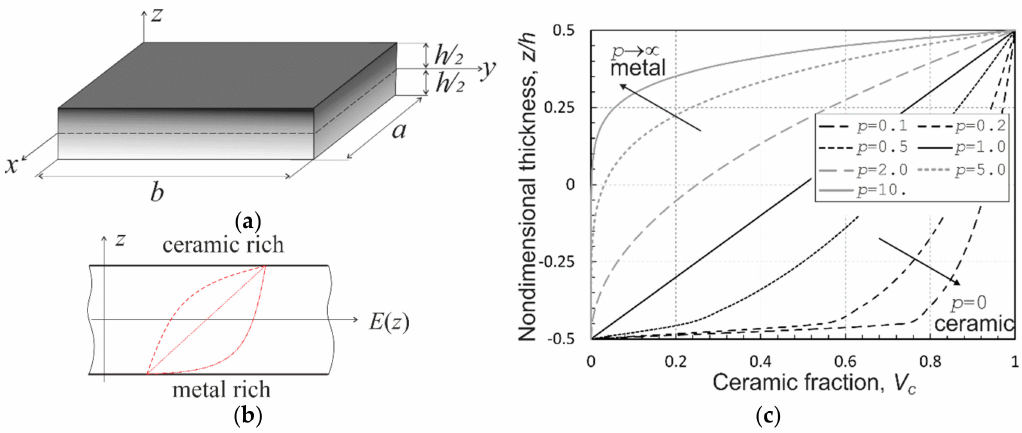
Figure 1. Sketches of: ( a ) functionally gradient material (FGM) sandwich panel; ( b ) through-the-thickness gradations of material properties; and ( c ) variations of ceramic volume fraction variations for various power-law indexes p